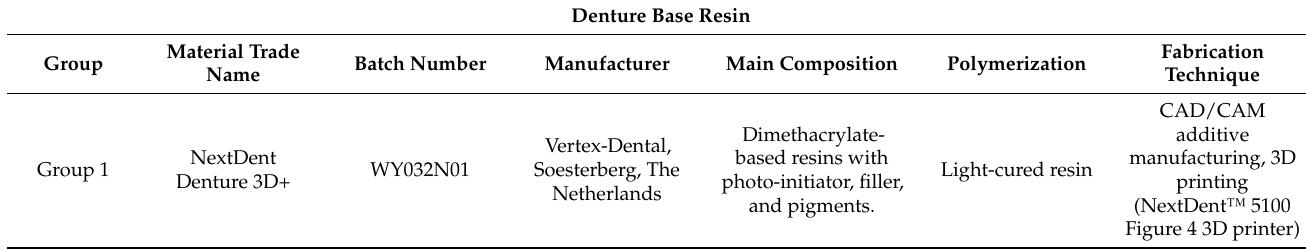
Table 1. Commercial names and details of materials used in the